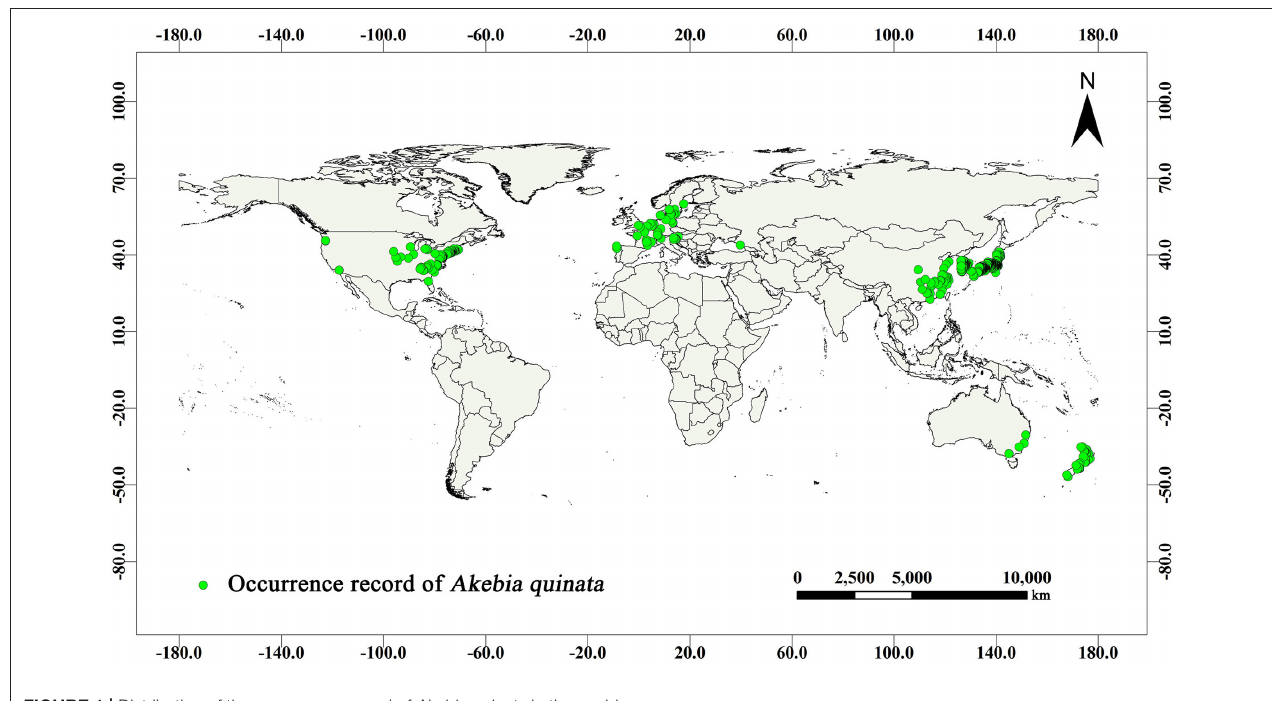
FIGURE 1 | Distribution of the occurrence record of Akebia quinata in the world.